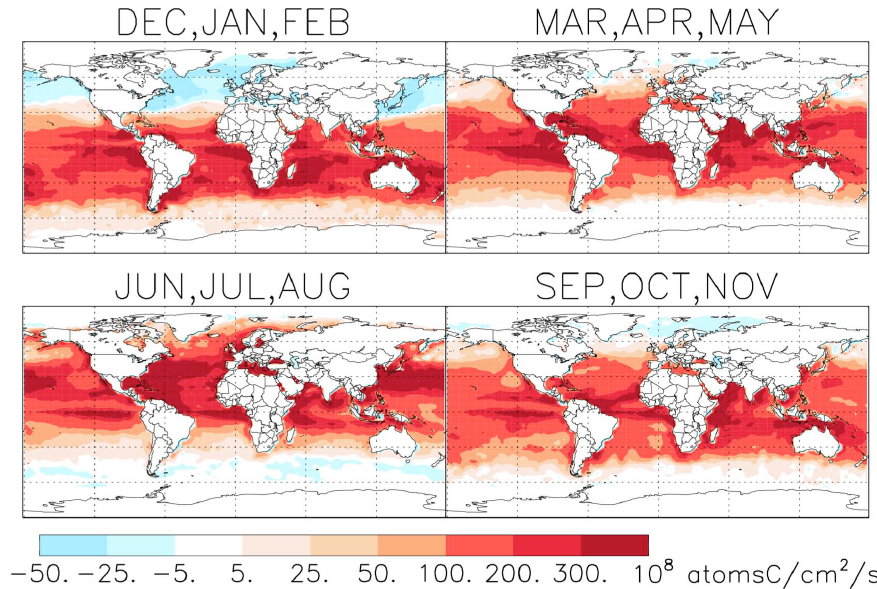
Fig. 6. Net simulated air-sea acetaldehyde flux averaged by season. Red colors indicate a net source of atmospheric acetaldehyde, blue colors a net